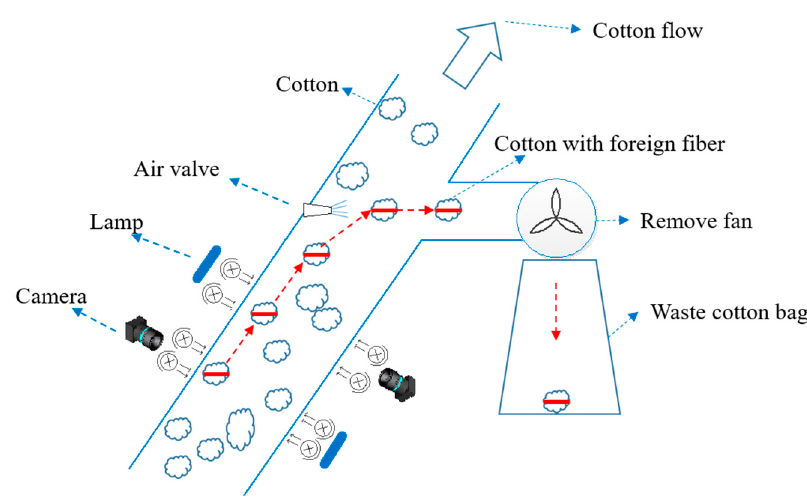
Figure 2. Working principle of a foreign fiber cleaning machine.